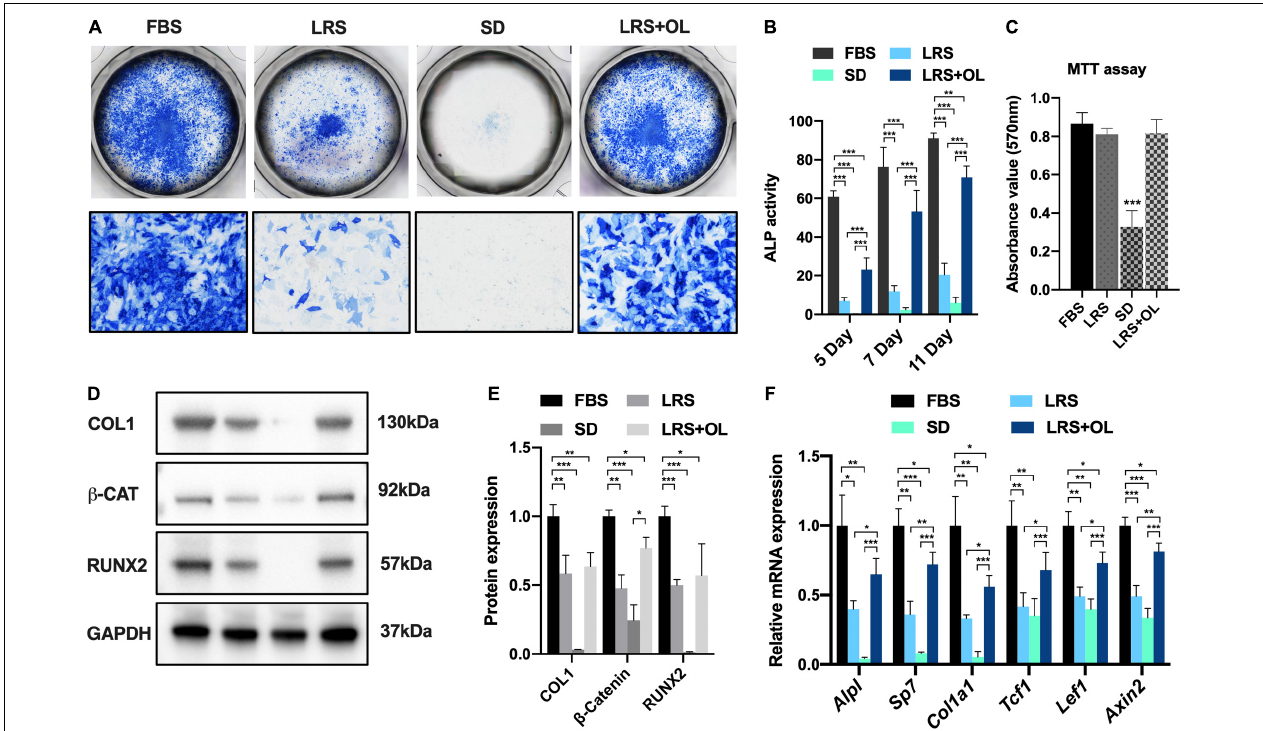
FIGURE 1 | Lipid scarcity suppressed bone marrow mesenchymal stromal cell (BMSC) osteogenesis and Wnt/beta-catenin signaling activation. (A) Alkaline phosphatase (ALP) staining of BMSCs 7 days after osteogenic induction in culture medium with normal fetal bovine serum (FBS; 10%), lipid-reduced serum (LRS; 10%), SD, and LRS (10%) with 75 µ M oleate treatment. (B) ALP activity of BMSCs 5, 7, and 11 days after osteogenic induction in different culture mediums. (C) Methylthiazolyldiphenyl-tetrazolium bromide (MTT) assays revealed significantly decreased cell viability in SD treatment BMSCs compared to FBS